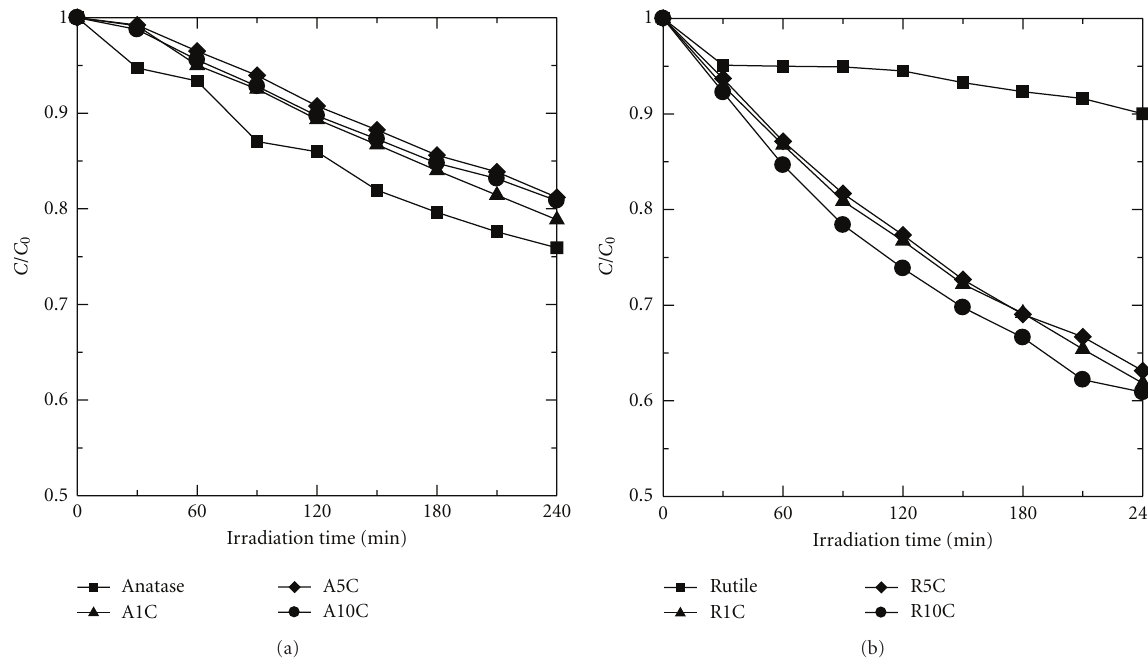
Figure 8: Changes of the MB concentrations decomposed by the samples as a function of visible light irradiation time (10,000 lx). (a) The anatase, A1C, A5C, and A10C samples, (b) The rutile, R1C, R5C, and R10C samples.